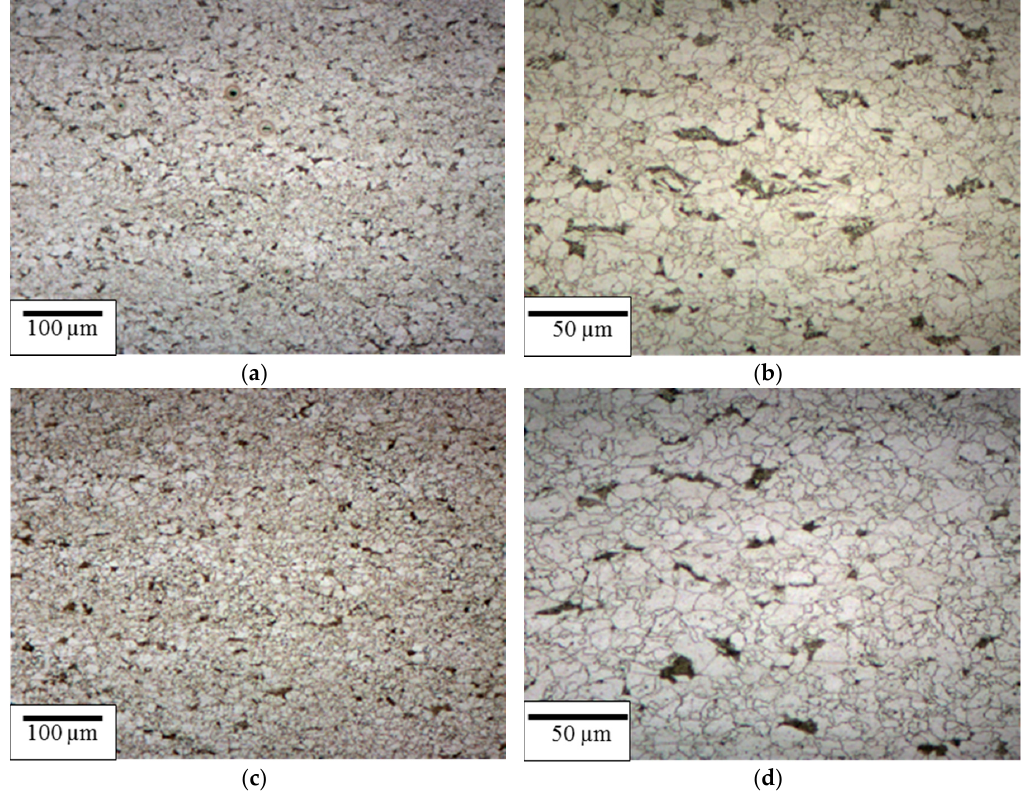
Figure 4. Typical microstructures observed in steel samples: ( a ) Heat A (magnification of ×200); ( b ) Heat A (magnification of ×500); ( c ) Heat B (magnification of ×200); ( d ) Heat B (magnification of ×500).